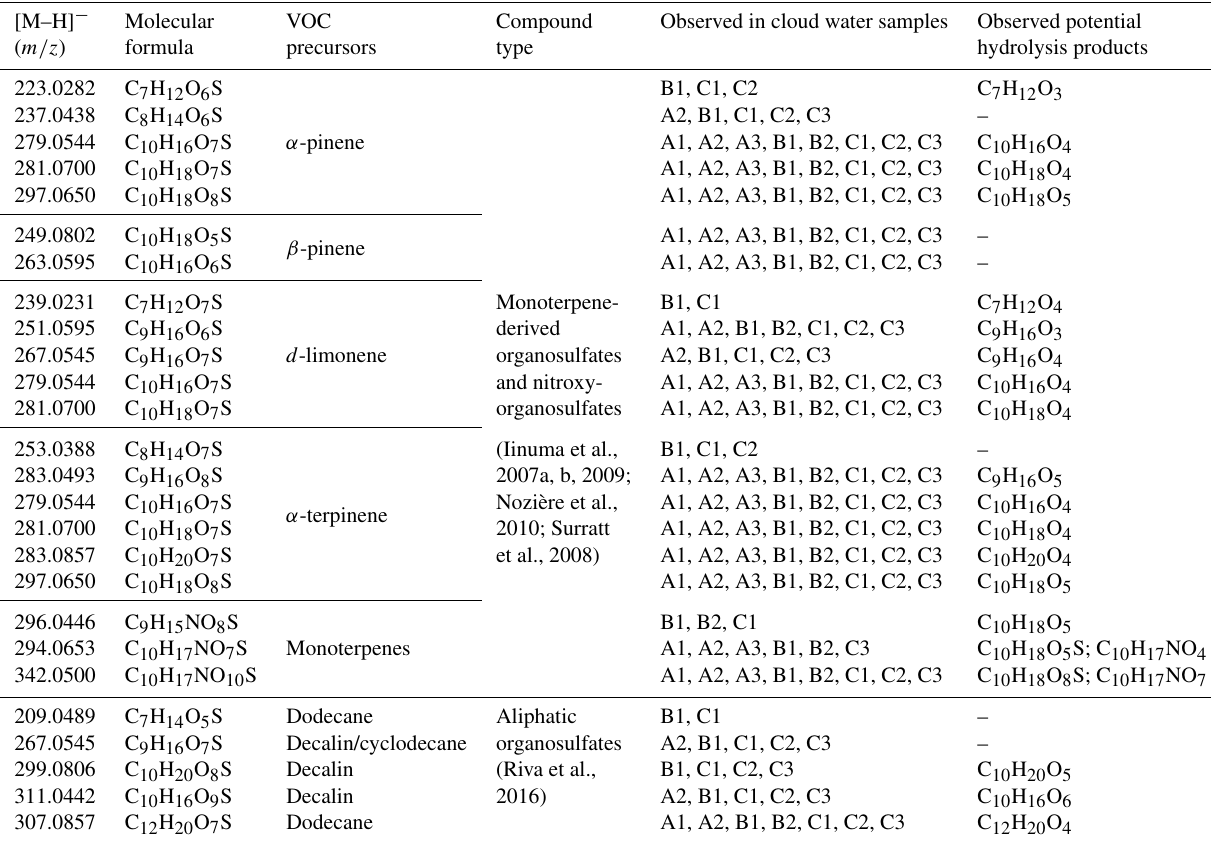
Table 2. Identified SOA tracers ( m/z , neutral molecular formula, suggested volatile organic compound (VOC) precursor, and compound type, based on previous laboratory chamber studies) in each cloud water sample, with observed potential hydrolysis products of likely organosulfates